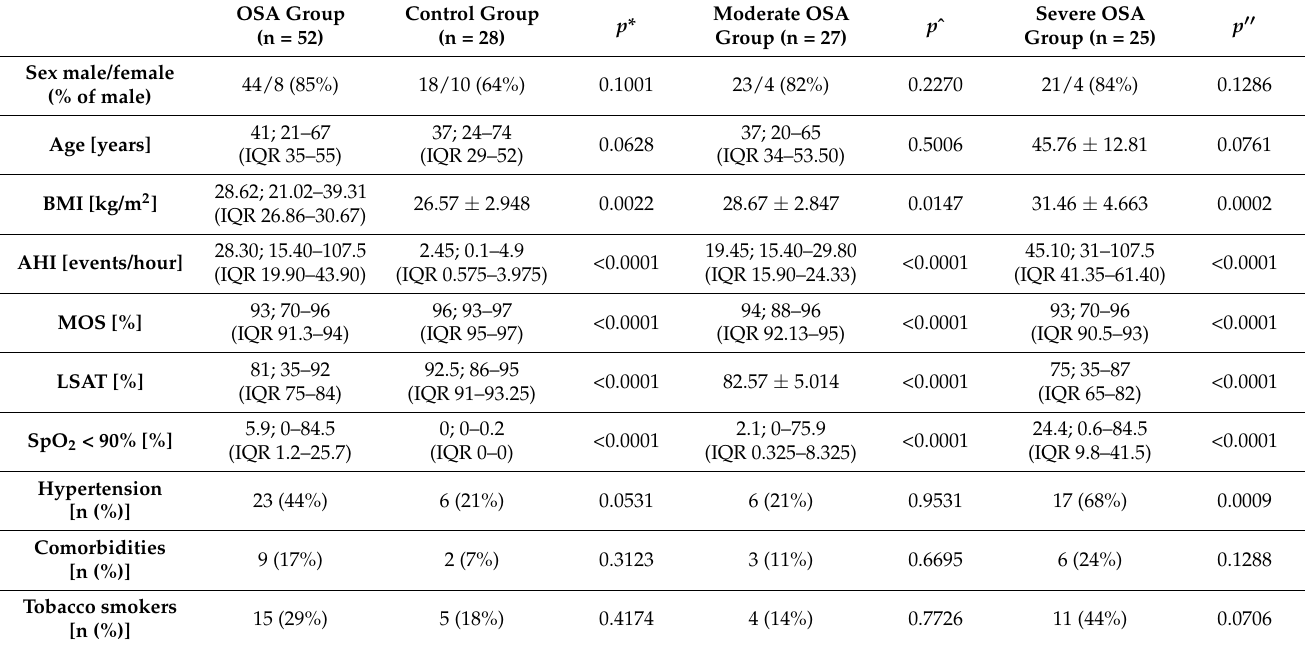
Table 1. Demographic, anthropometric, and biological characteristics of the OSA and non-OSA participants of the